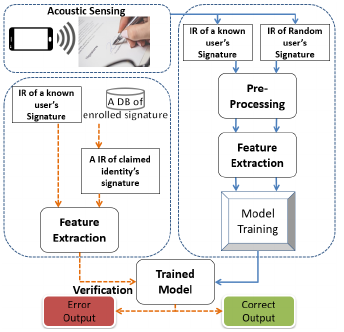
Figure 1. The system architecture of